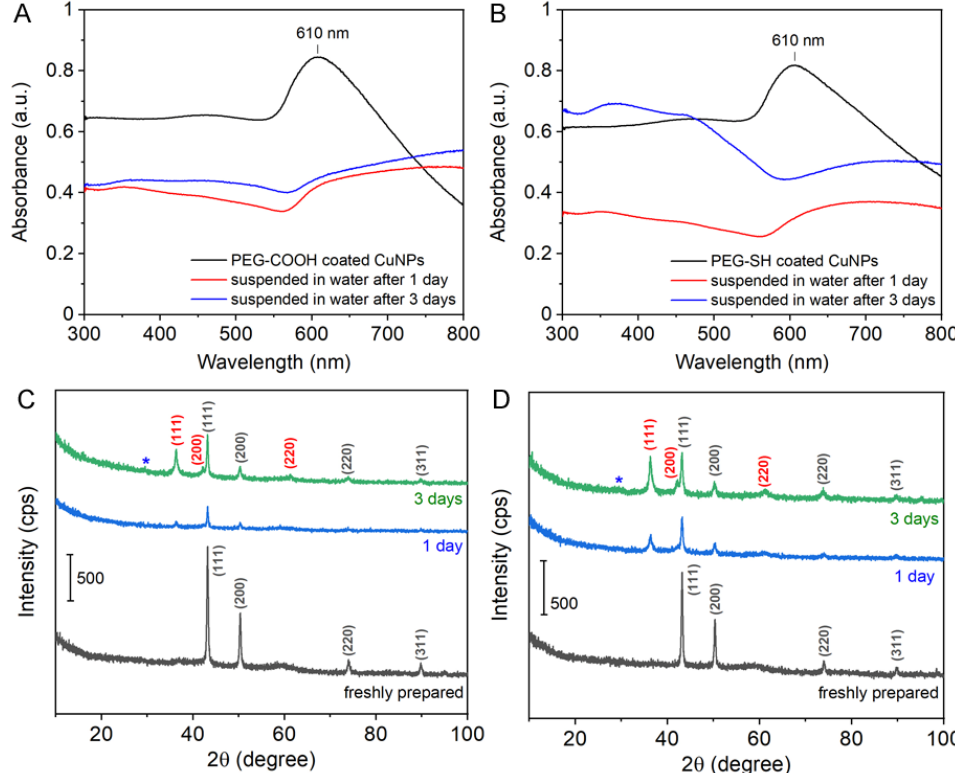
Figure 2. ( A , B ) UV-vis spectra of PEGylated CuNPs: ( A ) PEG-COOH; and ( B ) PEG-SH. Spectra in black, red, and blue were taken immediately after, after 1 day, and 3 days suspended in water, respectively. ( C , D ) XRD of the PEGylated CuNPs: ( C ) PEG-COOH; and ( D ) PEG-SH. The reflection peaks labeled in black and red are corresponding to the indices for fcc Cu and cubic Cu 2 O, respectively. The peak labeled with blue star is indexed to (002) of monoclinic CuO.